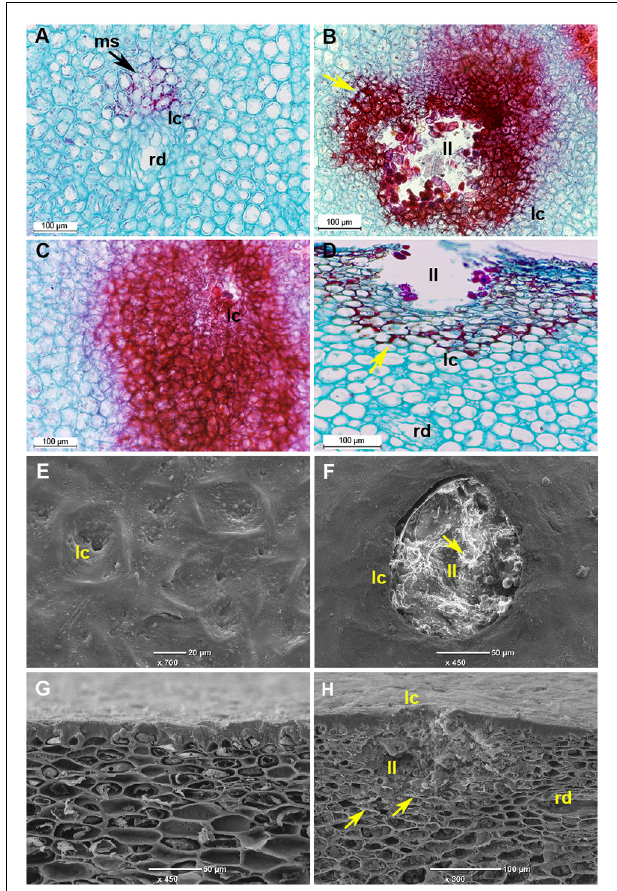
FIGURE 5 | Microscopic evaluation of discolored mango fruit lenticels after 19 days of cold storage. (A–D) Histological sections of ‘Keitt’ mango peel stained with safranin and fast green after 3 weeks of cold storage. (A) Transverse section of peel of mango stored at 12 ◦ C, showing healthy lenticels. (B,D) Transverse and paradermal sections of mango stored at 5 ◦ C, respectively, showing discolored lenticels with phenolics accumulation (stained in red). (C) Transverse section of mango stored at 5 ◦ C showing higher accumulation of phenolics surrounding pitting. (E–H) Scanning electron microscopic images after 3 weeks of storage. (E) Top view and (G) cross section of healthy lenticels of mango fruit stored at 12 ◦ C. (F) Top view and (H) paradermal section of discolored lenticels of mango fruit stored at 5 ◦ C, respectively, showing lenticels’ deeper lumen (ll) with accumulation of dead cells. ms, modified stomata; ll, lenticel lumen; lc, lenticel; rd, resin duct; yellow arrow, phenolic